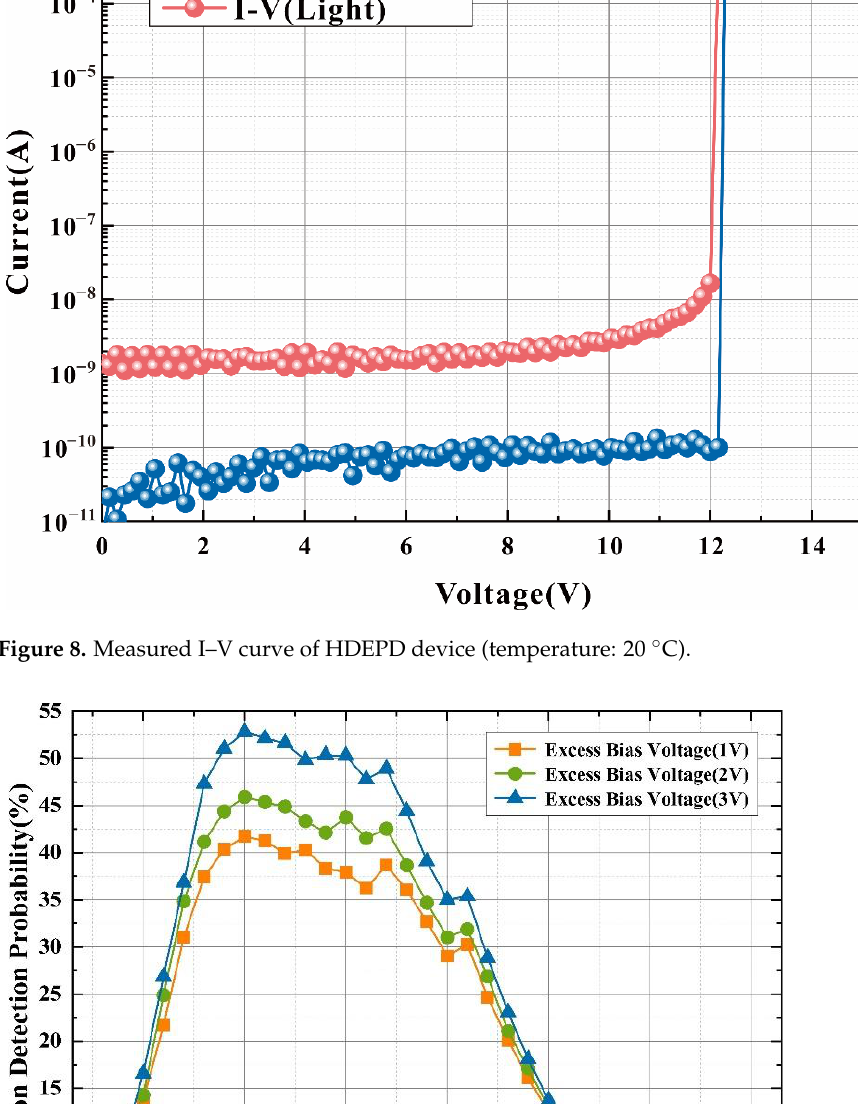
Figure 9. Measured PDP curve of HDEPD device (temperature: 20 °C).